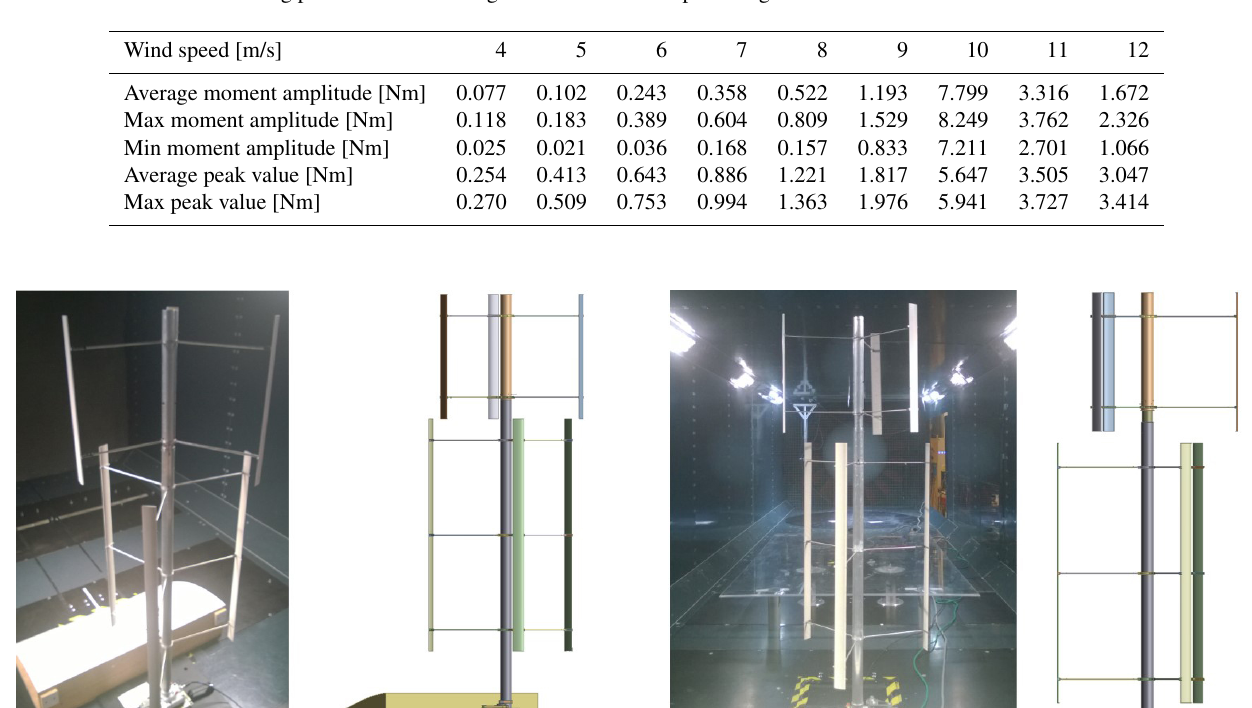
Table 1. Control case K testing parameters of bending moments for wind speed range.